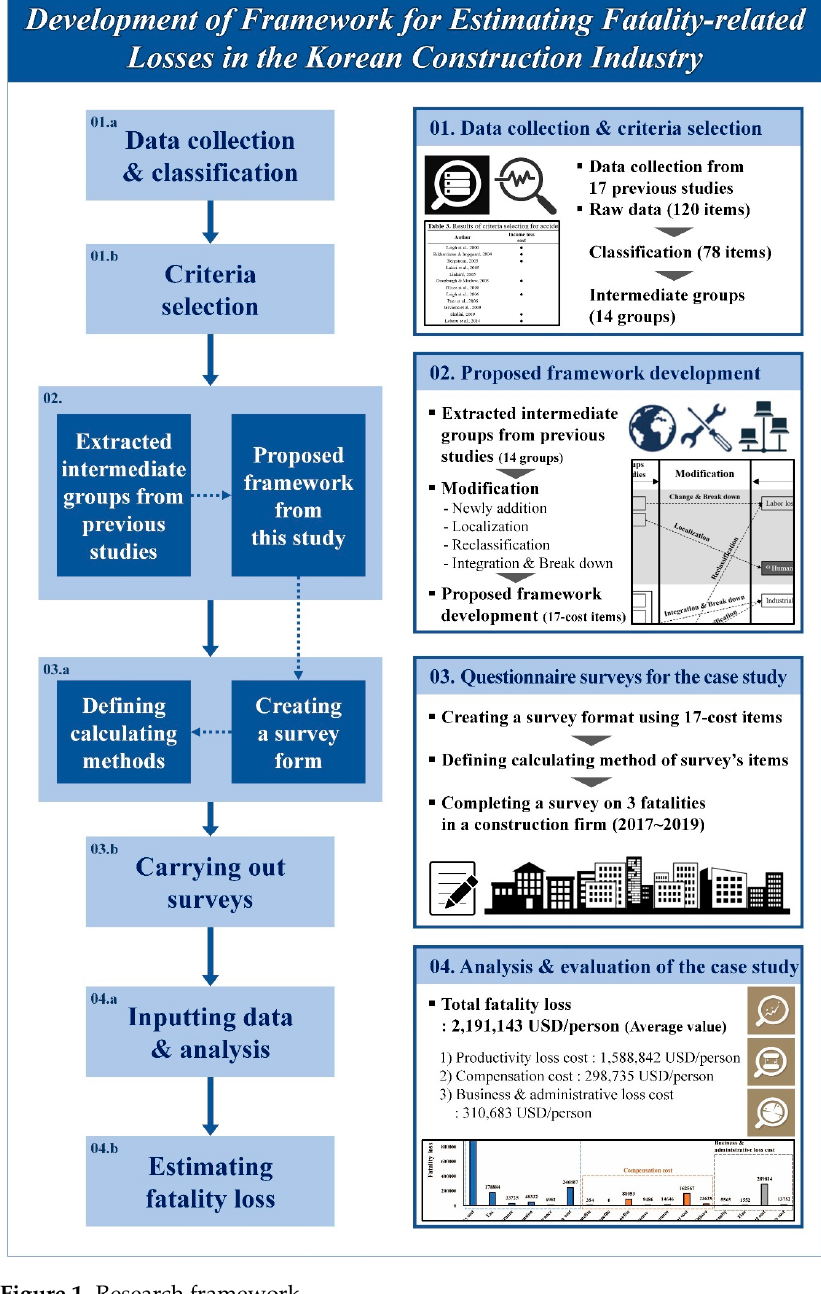
Figure 1. Research